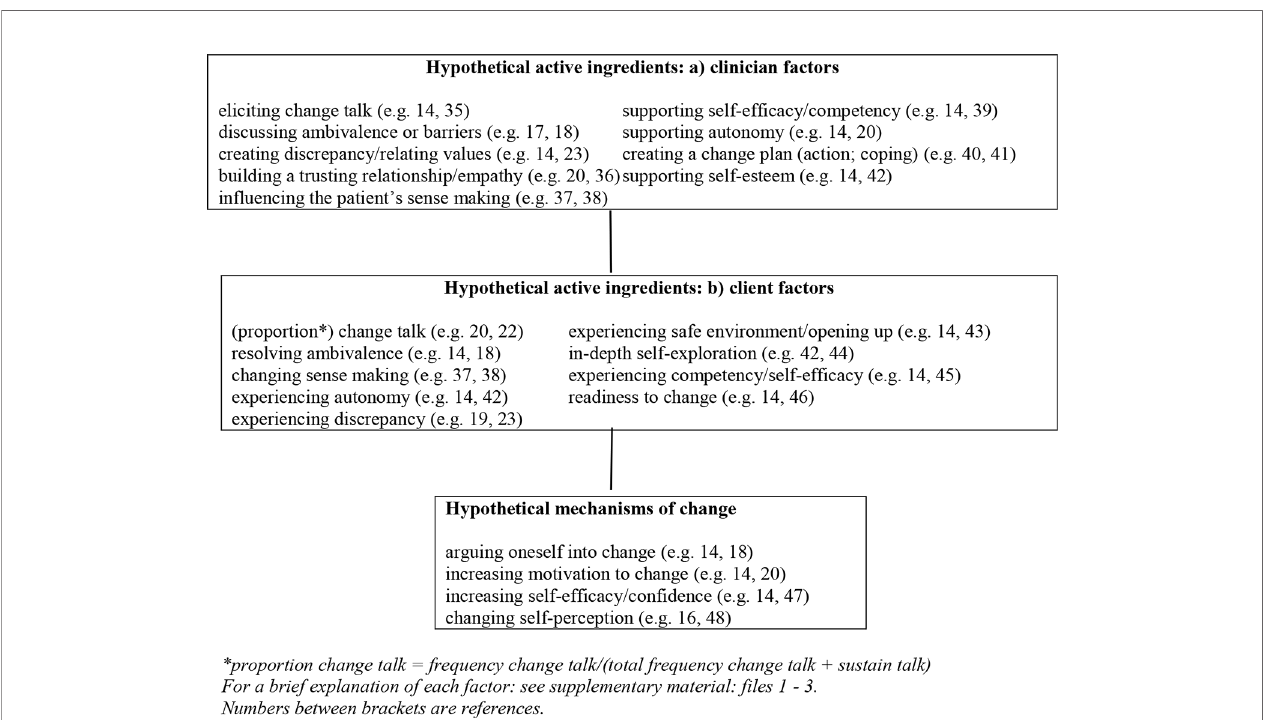
FIGURE 1 | Model of hypothetical active ingredients and mechanisms of change in MI for medications adherence in patients with schizophrenia. *Proportion change talk = frequency change talk/(total frequency change talk + sustain talk). For a brief explanation of each factor: see Supplementary Material: File 1 – 3 . Numbers between brackets are